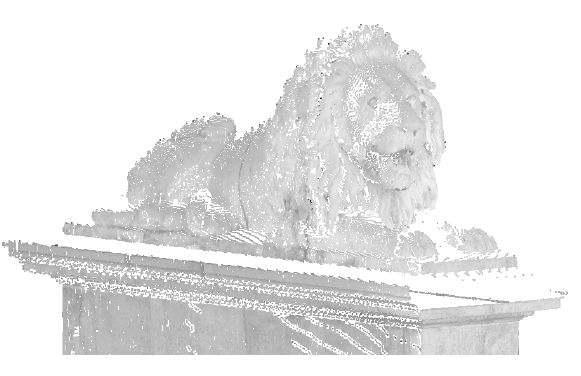
Figure 2. Reconstruction from TLS